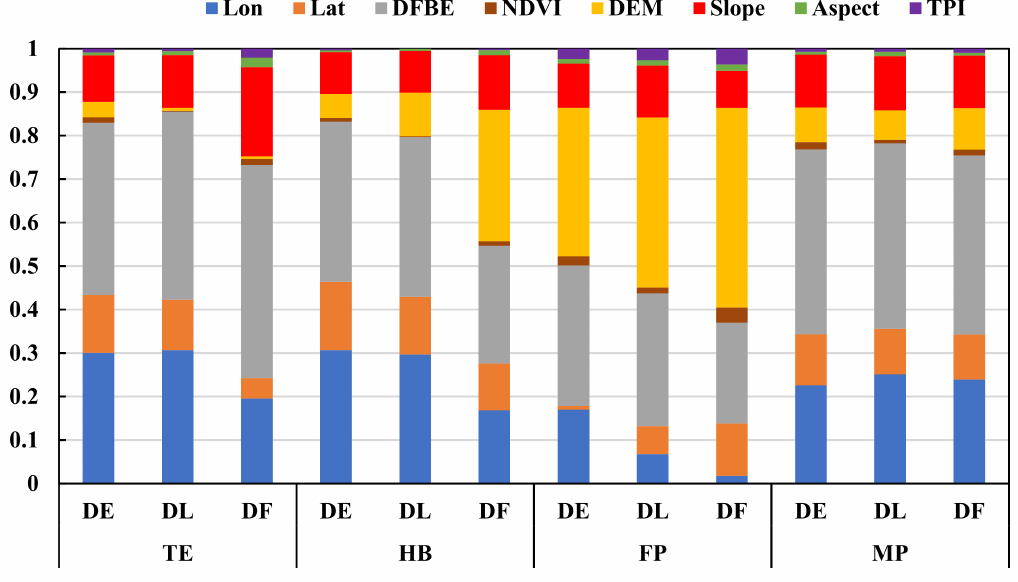
Figure 6. Same as Figure 2 but based on independent error